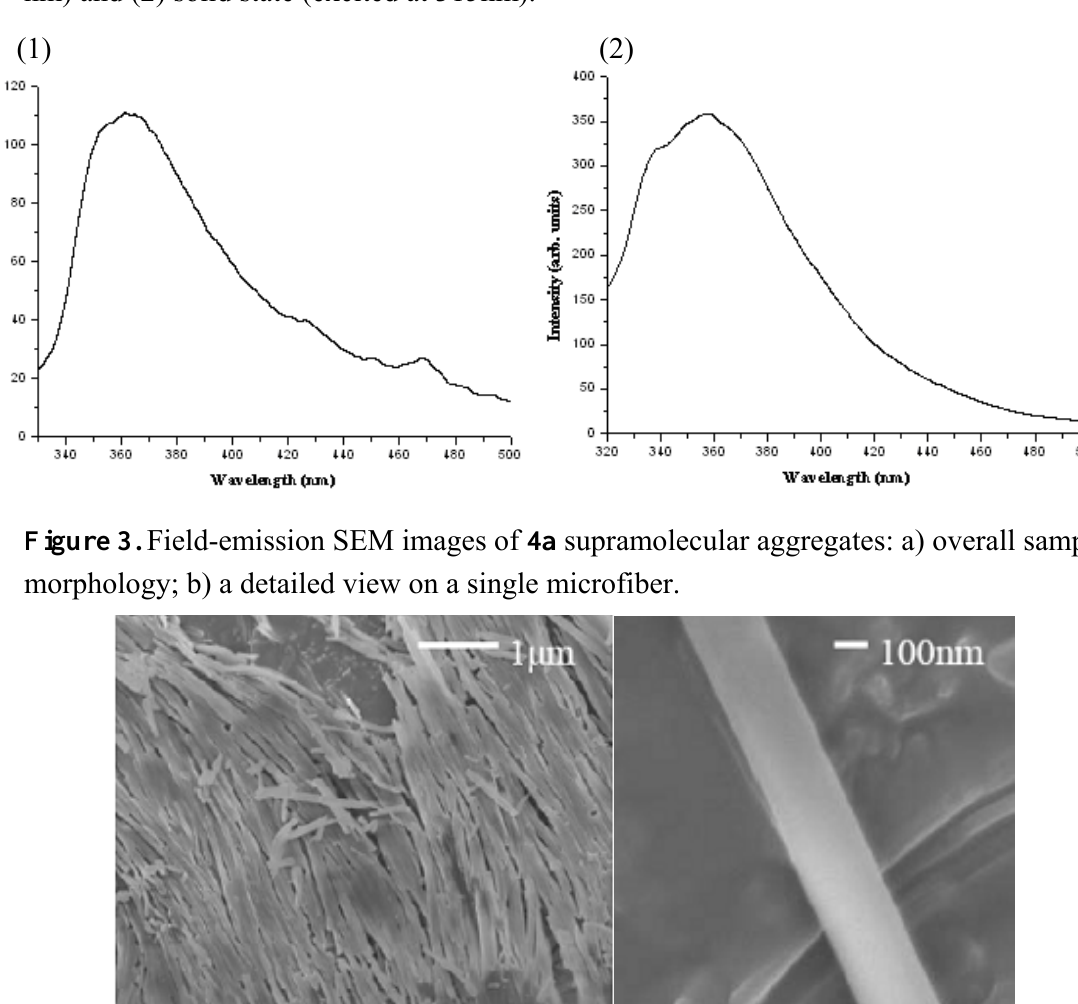
Figure 2. Emission spectrum of the 4a in (1) DMF solution (1×10 -5 M; excited at 302 nm) and (2) solid state (excited at 315nm).